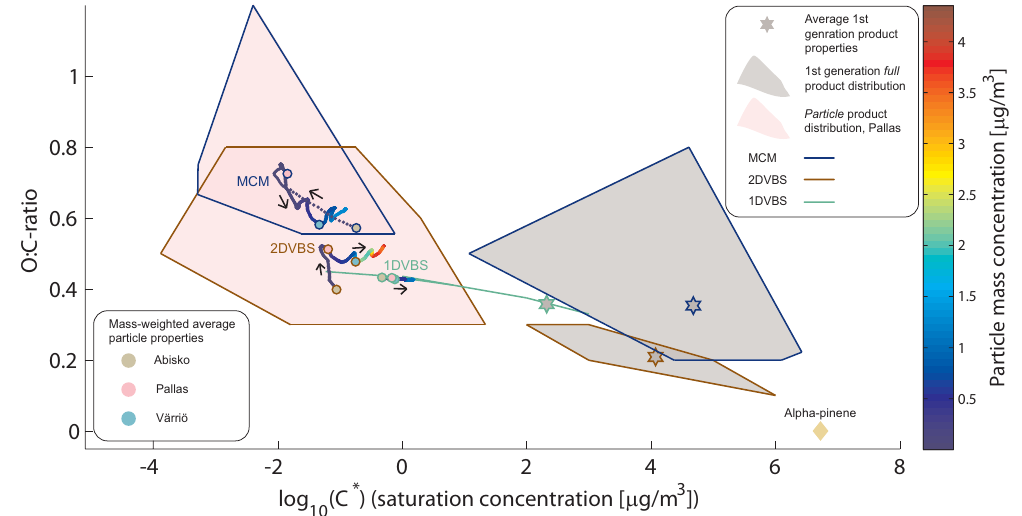
Figure 6. The full (gas or particle) first-generation distributions of the oxidation products in the MCM, 2DVBS and 1DVBS base case simulations are shown as grey areas enclosed with lines, representing each model simulation (MCM – blue, 2DVBS – brown and 1DVBS – green). The grey stars are the corresponding mass-weighted average properties of the first-generation products. The distributions of the products in particle phase in Pallas are shown as pink areas. Also shown, for all three model simulations, are the time evolutions (in the direction of the respective arrows) of the mass-weighted average particle properties and SOA concentration along the air-mass trajectory starting from Abisko (beige circles) and passing Pallas (pink circles) and Värriö (blue